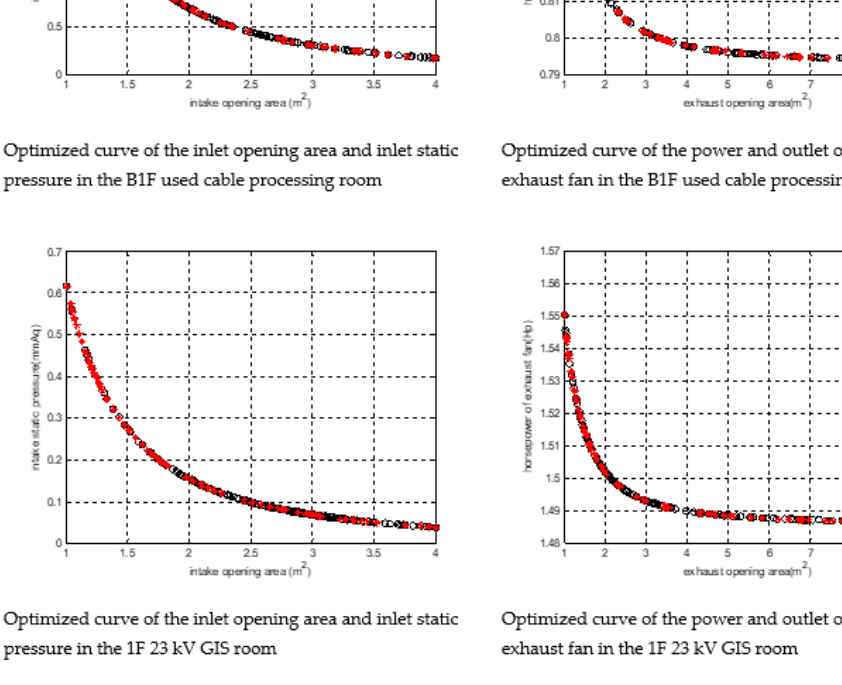
Figure 4. Dual MOPSO optimization simulation results in the substation (red stars represent the local best; black circles represent the global best). Table 4. Benefit analysis of MOPSO optimization (roof